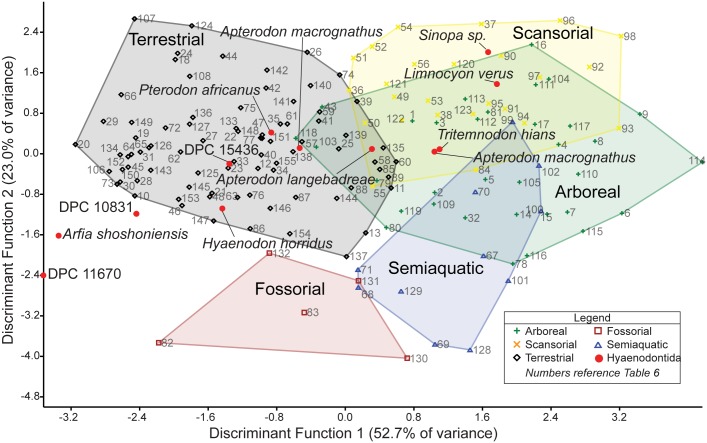
Locomotor categorization of hyaenodont humeri on DF1 and DF2.The results of discriminant function analysis for DF1 (explains 52.7% of variance) plotted against DF2 (explains 23.0% of variance). The analysis is based on 20 linear measurements (see Fig 2) collected for 155 carnivoran specimens (55 species) and 12 hyaenodont specimens (8 species). Numbers correspond to specimen numbers in Table 5, S4 and S5 Tables. Refer to Table 6 and S5 Table for classification of the hyaenodontan sample. Refer to Table 7 for measurements loadings. Each point represents a specimen, not a species mean. Green plus, Arboreal carnivoran specimens; Yellow X, Scansorial carnivoran specimens; Black diamond, Terrestrial carnivoran specimens; Red squares, Fossorial carnivoran specimens; Blue triangles, Semiaquatic carnivoran specimens; Red dots, hyaenodontans with unassigned locomotor behaviors.